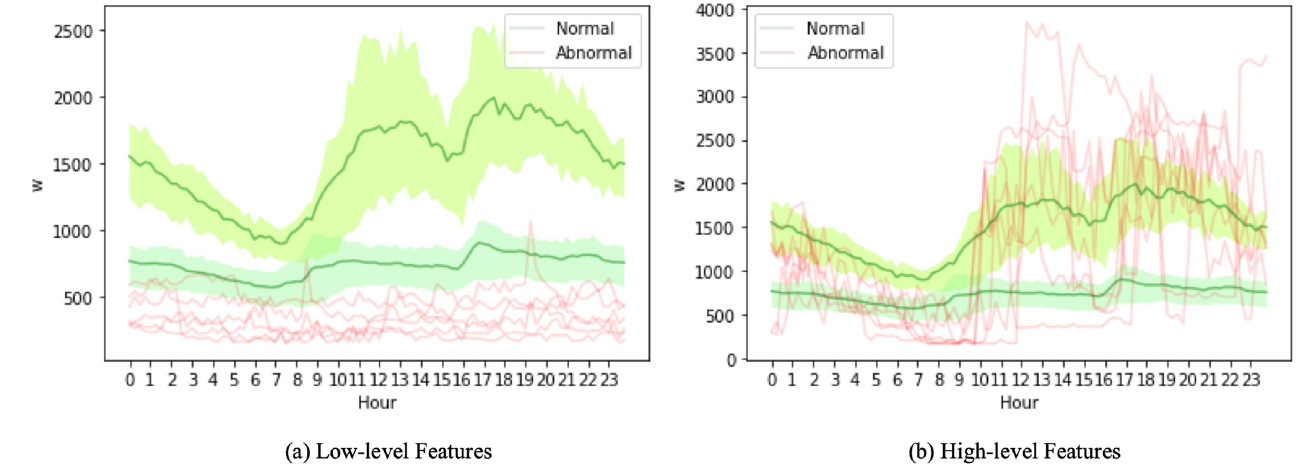
Figure 5. Load profiles of the main and abnormal electricity consumption events of User 01.